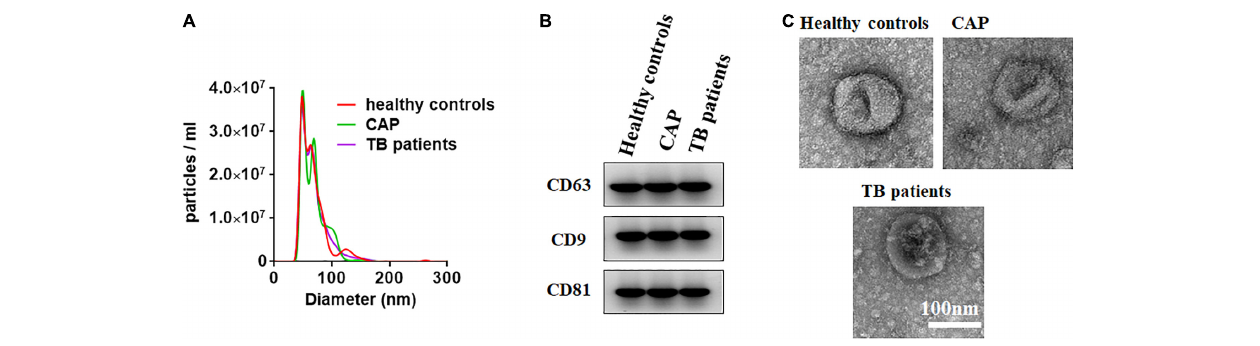
FIGURE 1 | Characterization of small extracellular vesicles derived from the serum. (A) The size of small extracellular vesicles derived from serum of healthy controls, active pulmonary TB patients and community-acquired pneumonia (CAP) patients. (B) Western blots of exosomal membrane markers, including CD63, CD9, and CD81. (C) Shape and structure of serum exosomes isolated by ultracentrifugation under